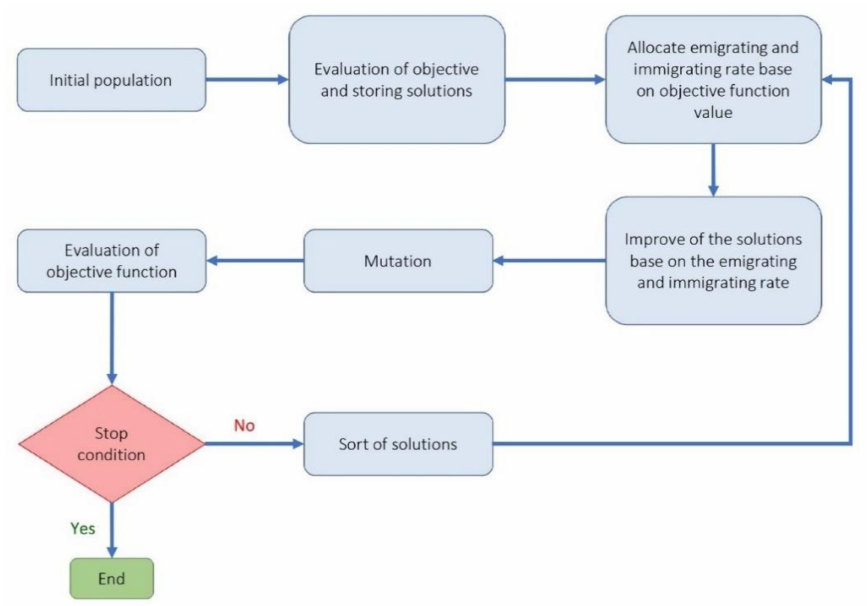
Figure 5. Flowchart of biogeography-based optimization algorithm.